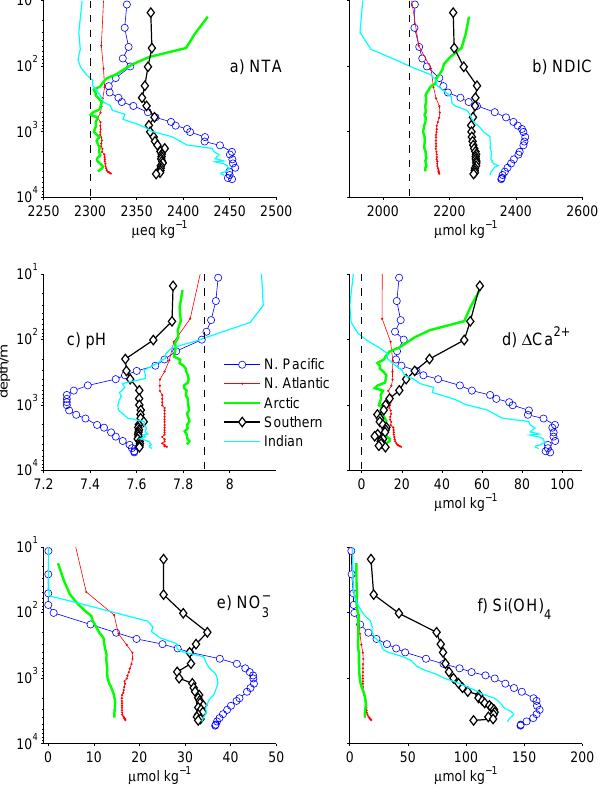
Fig. 6. Composition anomalies for example stations: North Pacific (WOCE line P17, station 34, 37.5 ◦ N, 135.0 ◦ W, 10 August 2001), North Atlantic (WOCE line A24, station 119, 52.73 ◦ N, 34.71 ◦ W, 22 June 1997) Arctic (AO94 station 29, 87.16 ◦ N, 160.71 ◦ E, 17 August1994) Southern Ocean (WOCE line S04, station 29, 62.02 ◦ S, 134.18 ◦ E, 9 January 1995) and Northern Indian Ocean (WOCE line I05, station 297, 1.33 ◦ N, 80.00 ◦ E, 13 March 1995). (a) Normalized TA for all profiles (NTA=TA × 35 /S P ). (b) Nor- malized DIC (NDIC=DIC × 35 /S P ). (c) pH on the Total scale. (d) Computed change 1 Ca 2 + (e) NO − . (f) Si ( OH ) 4 . Vertical 3 dashed lines show values in SSW76.